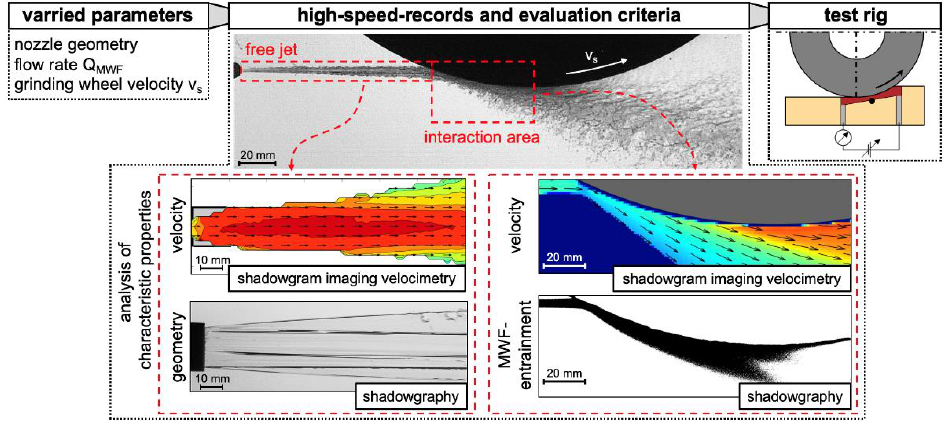
Figure 2. Procedure for analyzing and characterizing the coolant supply.